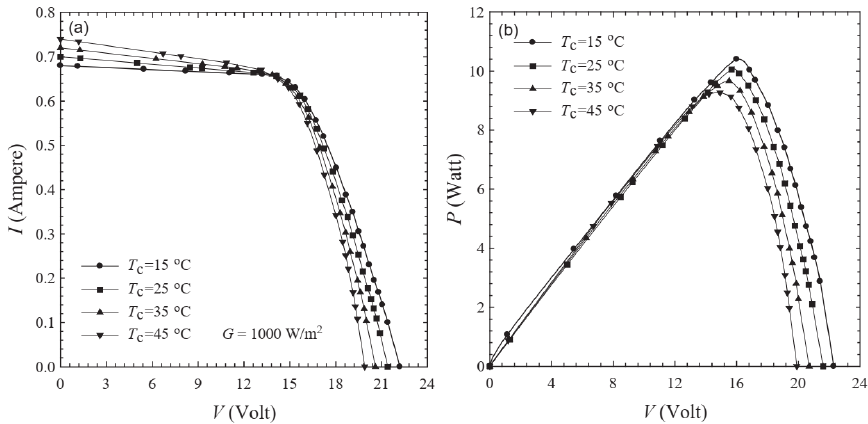
Figure 1. ( a ) I-V ( b ) P-V Characteristic curves of the PV cell at different temperatures. Reprinted with permission from ref. [66]. Copyright 2014 Taylor & Francis.